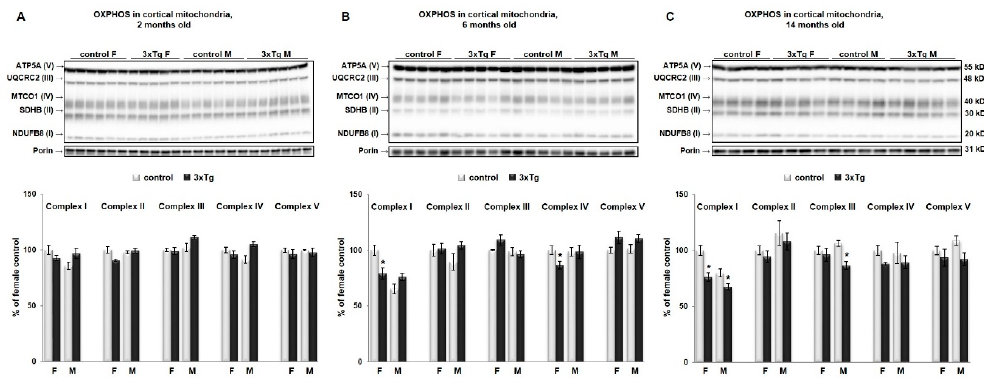
Figure 2. Relative levels of OXPHOS proteins in cortical mitochondria of 3xTg mice and their respective controls. Representative WBs (upper panels) for Complex I (NADH dehydrogenase beta subcomplex subunit 8, NDUFB8), Complex II (succinate dehydrogenase subunit B, SDHB), Complex III (cytochrome b-c1 complex subunit 2, UQCRC2), Complex IV (Cytochrome c oxidase subunit 1, MTCO1), and Complex V (ATP synthase subunit alpha, ATP5A) and relative quantification (lower panels) for protein levels of OXPHOS subunits normalized to porin, in 3xTg female and male mice and their respective controls at 2 months ( A ), 6 months ( B ) and 14 months of age ( C ). Results are expressed as